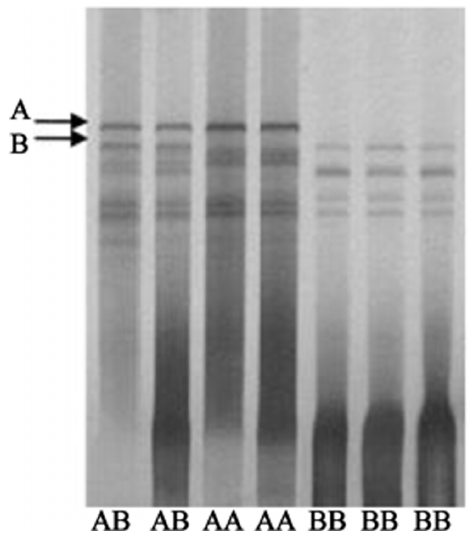
Figure 1. Non-denaturing polyacrylamide gel electrophore- sis, showing different single-strand conformation polymorphism (SSCP) variants in the HSP70 gene. AA (A258A), AB (A258G), and BB (G258G) genotypes were